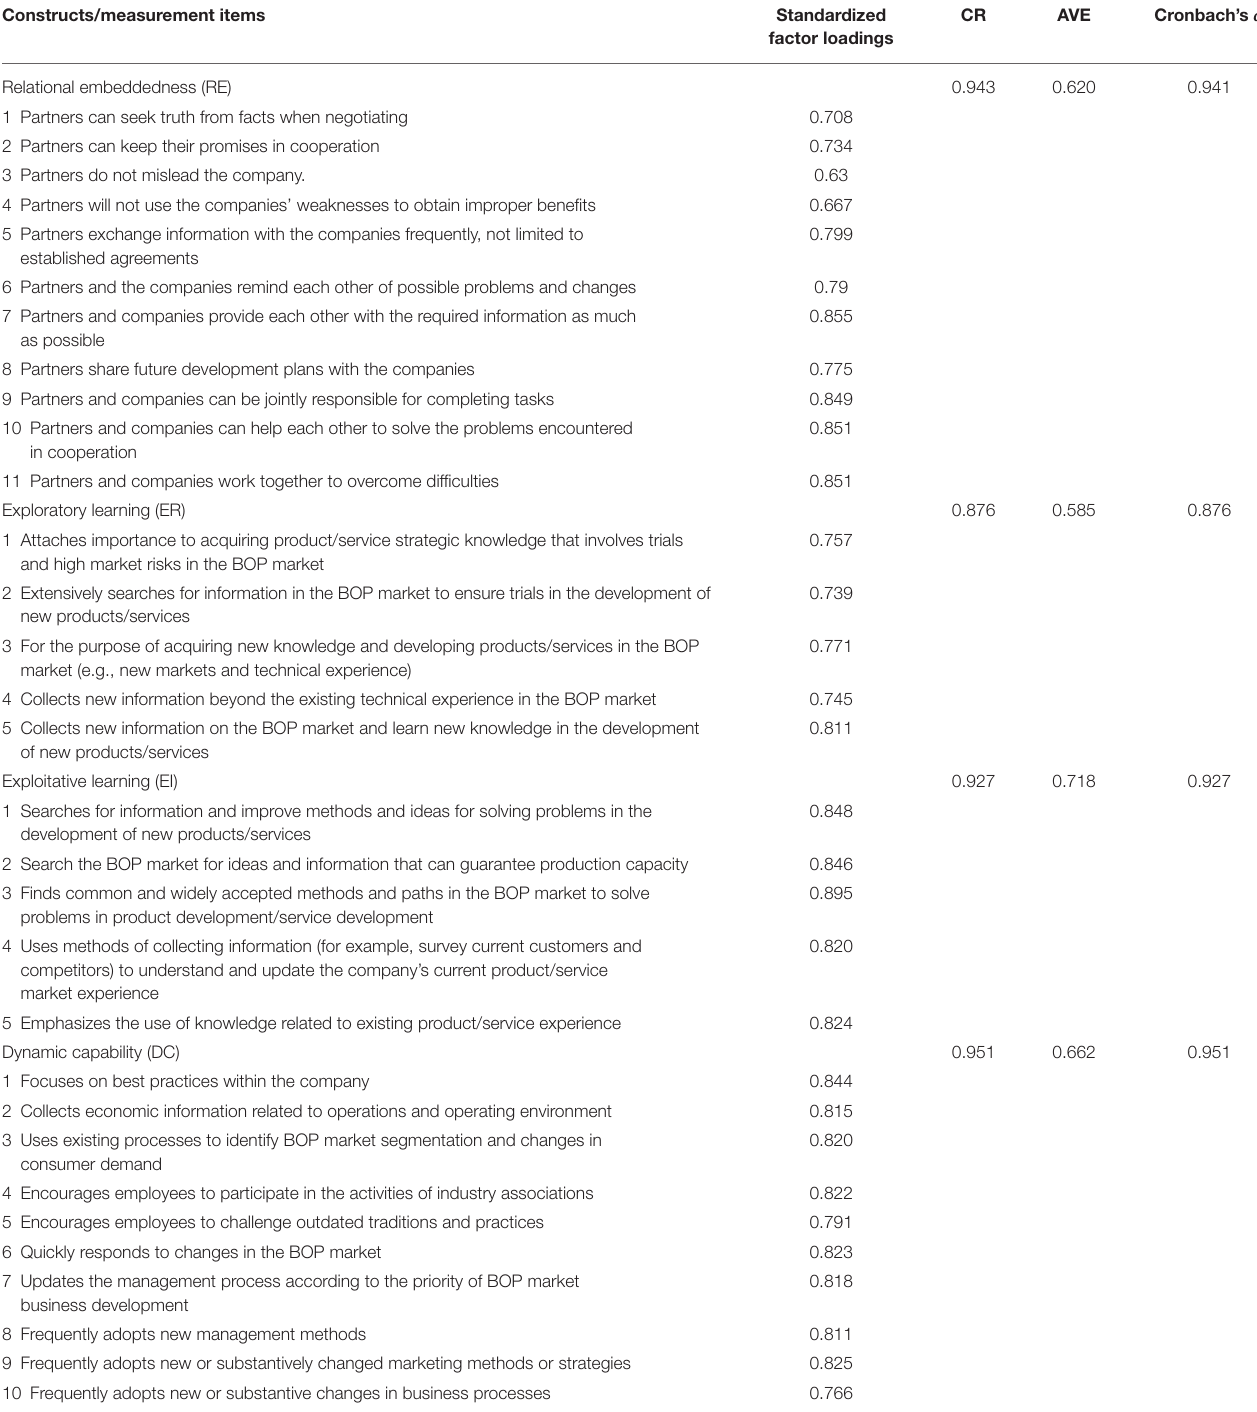
TABLE 1 | The test results for variable